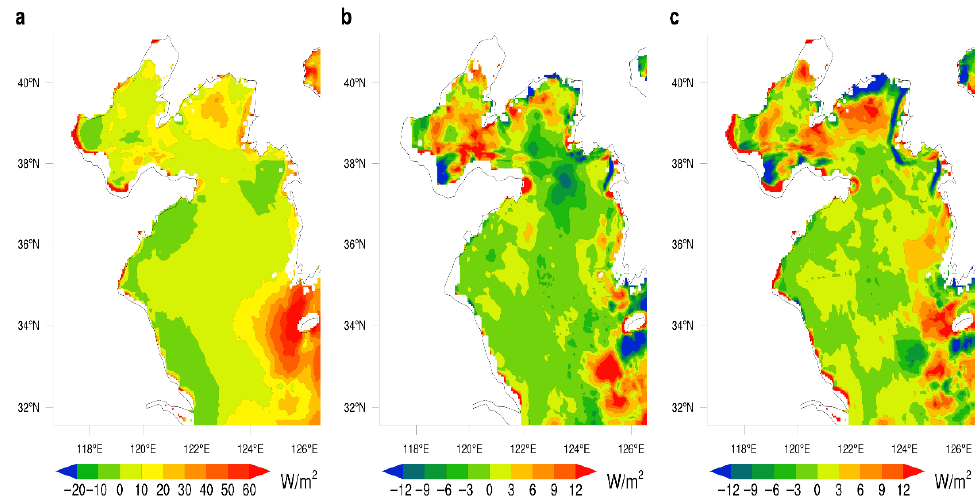
Figure 13. Sensible heat flux simulated using the 6h scheme and the difference compared with other schemes at 00:00 (UTC) on 20 February 2020. ( a ) Sensible heat flux of the 6h scheme; ( b ) difference in the sensible heat flux between the 6h scheme and daily scheme; ( c ) difference in the sensible heat flux between the 6h scheme and FNL scheme.